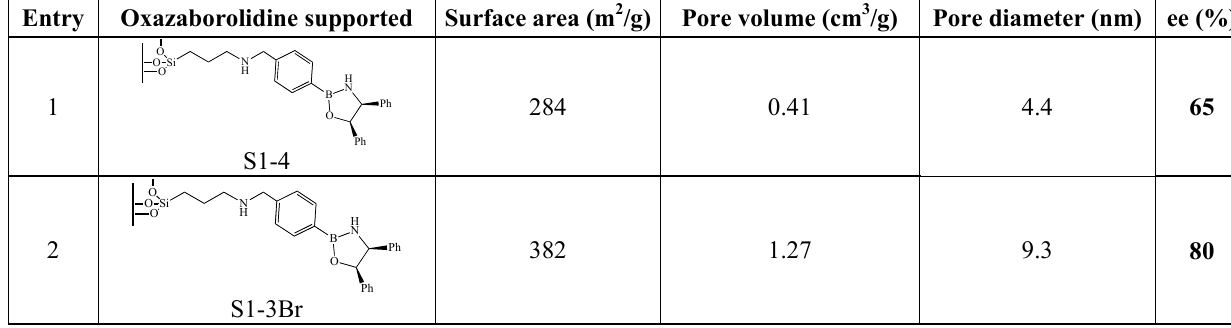
Table 8. Influence of the silica’s structural properties on enantioselectivity.